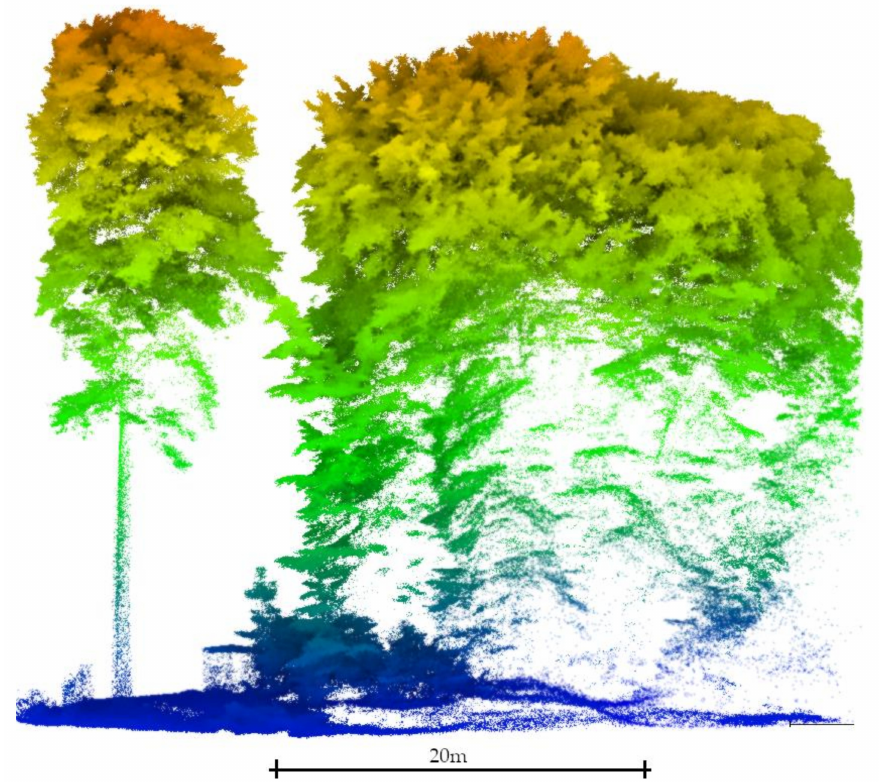
Figure 1. Difference in the point cloud signature between an isolated tree ( left ) and close trees with a high proportion of understory vegetation ( right ). The point density over the tree stem surface significantly decreases within the closed canopy patch and gaps in the data appear. This last situation depicts the conditions in which this study was carried